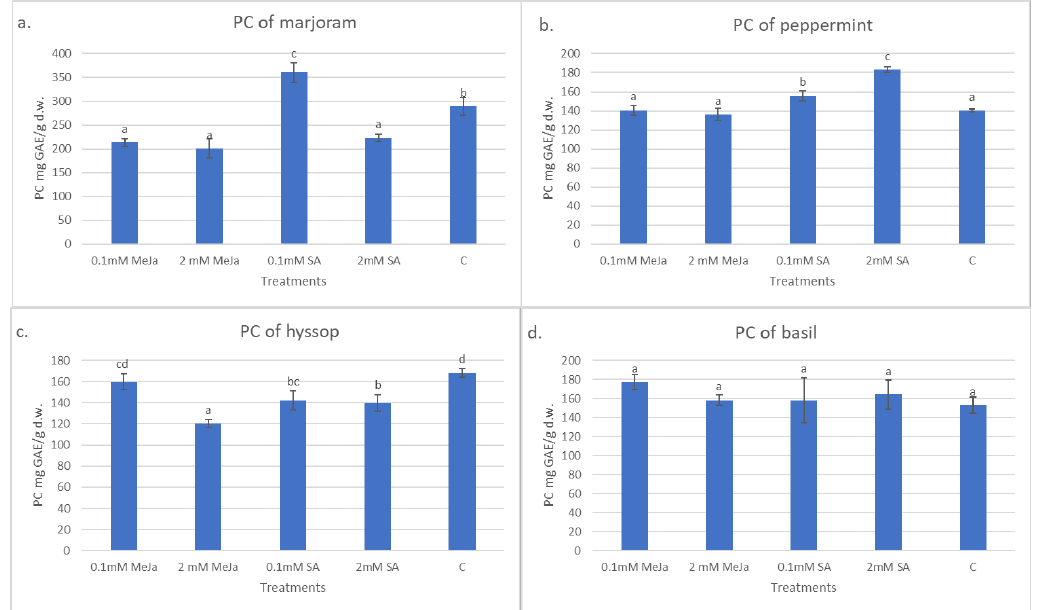
Figure 3. The effect of MeJa and SA on TPC of the subject species; ( a ) marjoram, ( b ) peppermint, ( c ) hyssop, and ( d ) basil; Data are expressed as means ± SD; means with different letters are signifi- cantly different ( p < 0.05).